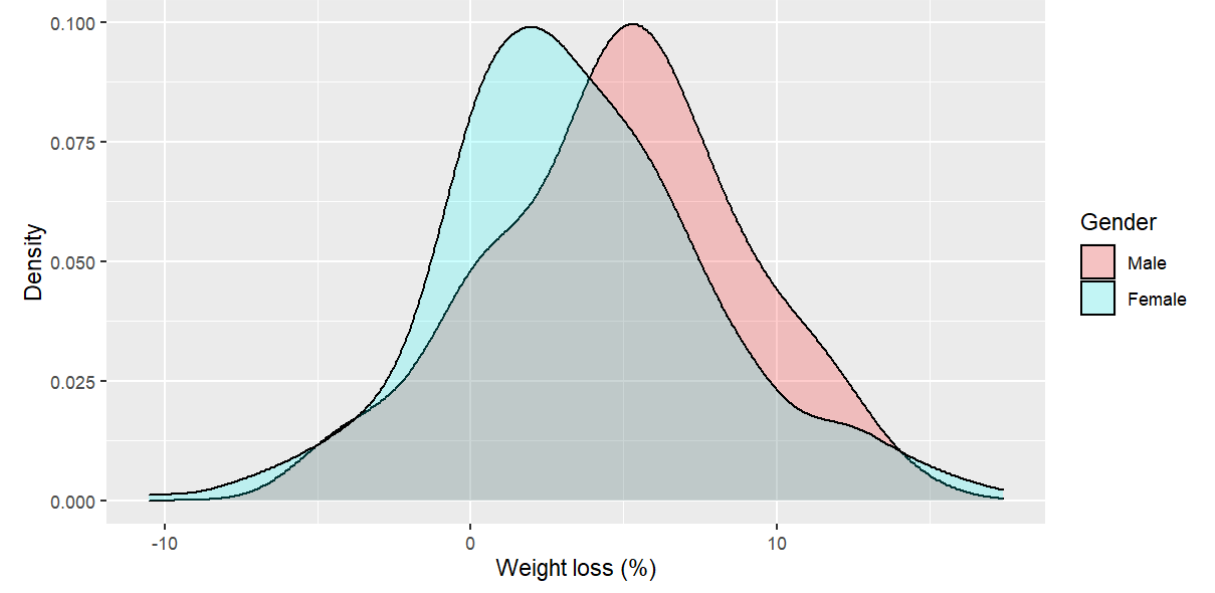
Figure 1. Weight loss (%) distribution by